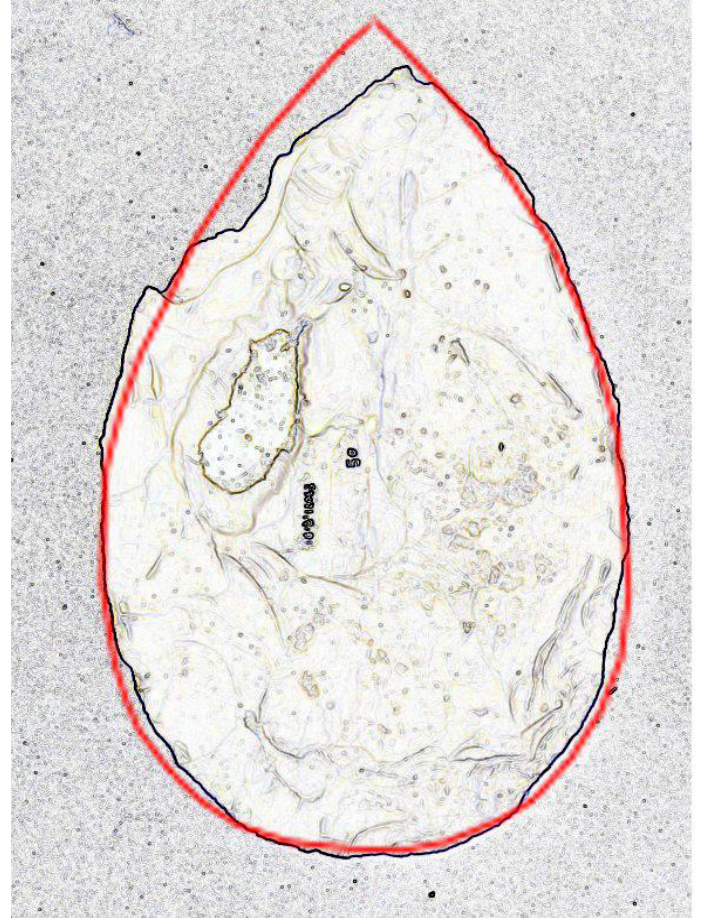
Figure 21. Geometry of pear cut diamond from Botswana superimposed on the outline of Specimen 12043-50B from